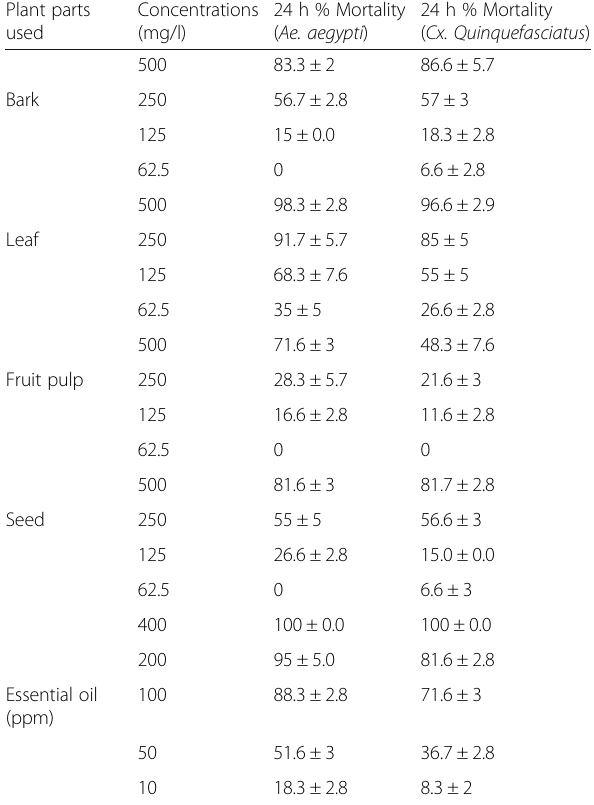
Values are given as mean±SD of triplicate